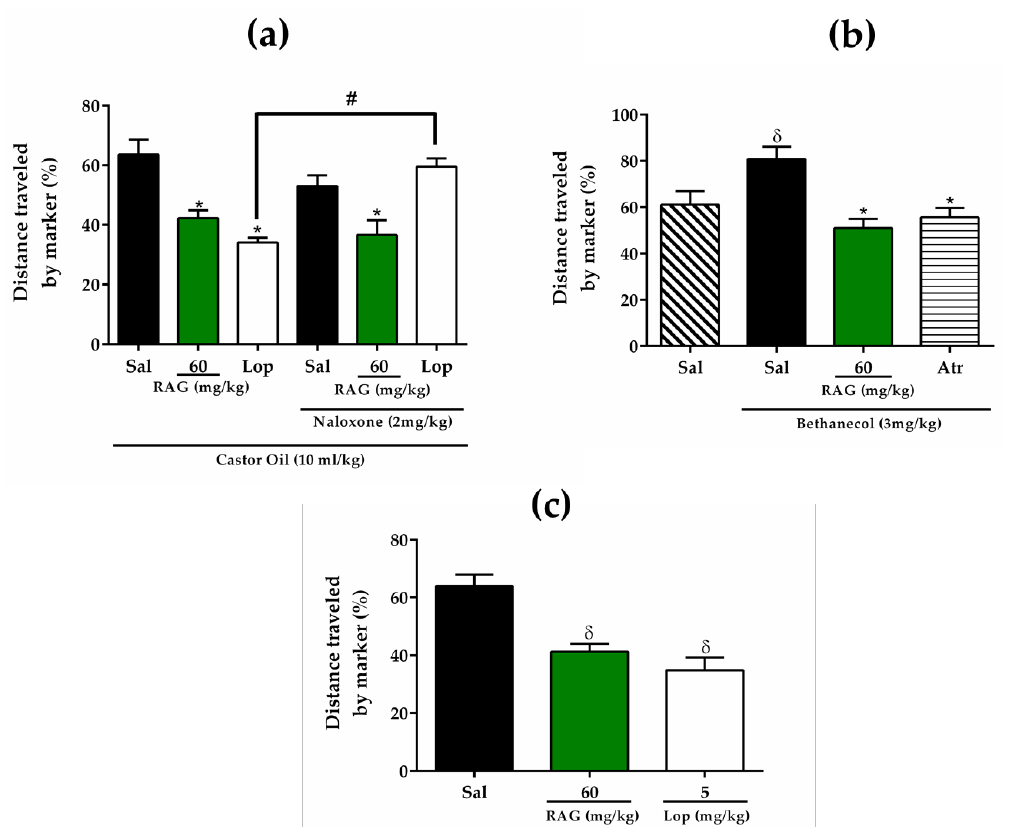
Figure 4. E ff ect of RAG on intestinal transit in mice. ( a ) E ff ect of naloxone on RAG activity in castor oil-induced intestinal transit in mice. Pre-treatment with RAG (60 mg / kg, p.o.) significantly reduced ( p < 0.05) the distance travelled by marker (charcoal) through the small intestine. The treatment with Loperamide (5 mg / kg, p.o.) had a similar anti-motility e ff ect. However, treatment with RAG in the group receiving naloxone (2 mg / kg, s.c.) did not reverse the anti-motility e ff ect of RAG, in contrast to loperamide. * p < 0.05 vs. saline group; # p < 0.05 loperamide + naloxone vs. loperamide alone. ( b ) Bethanechol, a cholinergic agonist, significantly increased the distance travelled by a charcoal meal through the intestine ( p < 0.05) compared to the saline treatment group. Pre-treatment with RAG (60 mg / kg, p.o.) reversed the stimulatory e ff ect of bethanechol (3 mg / kg, i.p.). ( c ) In the normal gastrointestinal transit model, pretreatment with RAG (60 mg / kg) showed a significant ( p < 0.05) inhibition in the gastrointestinal transit of the marker similar to loperamide. These results are expressed as mean ± SEM. Number of animals per group = 5–6. * p < 0.05 vs. saline + bethanechol group; δ < 0.05 vs. saline group. Statistics: one-way ANOVA with Tukey post-hoc test. Abbreviations: Lop = loperamide; RAG = red angico gum; Sal = saline; Atr = atropine.